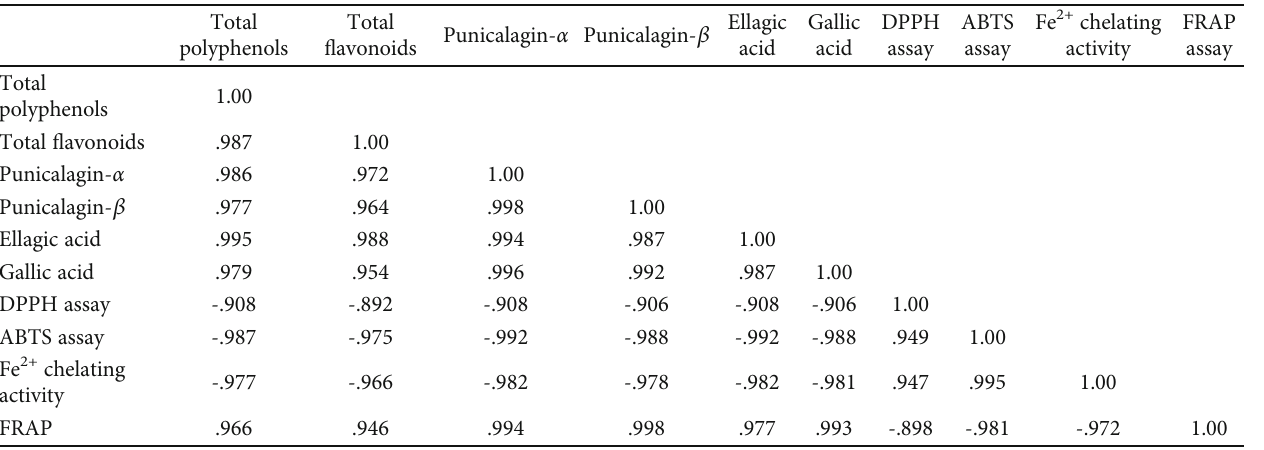
Table 3: Correlation between polyphenol compositions antioxidant